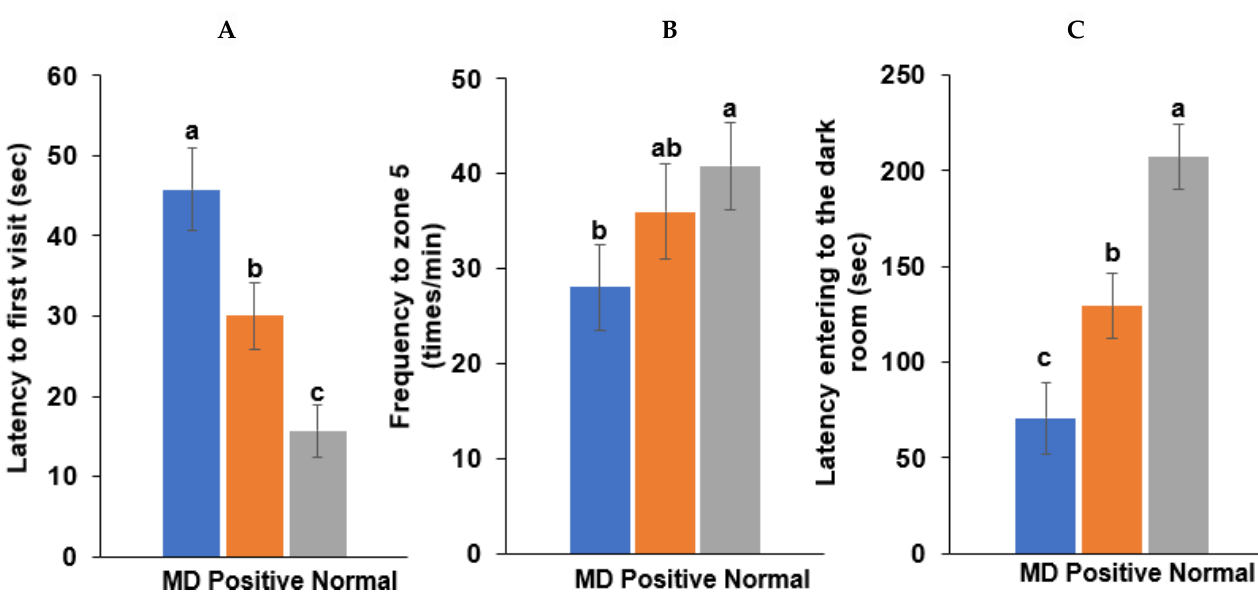
Figure 5. Memory function by the water maze and passive avoidance test in scopolamine-injected rats. ( A ). Latency time to first visit zone 5 in the water maze. ( B ). Frequency to zone 5 in the water maze. ( C ). Latency time entering the dark room in the passive avoidance test. Bars represent the means and standard deviations (n = 10). a,b,c Different letters on the bar indicated significant differences among the groups at p < 0.05 in each figure.